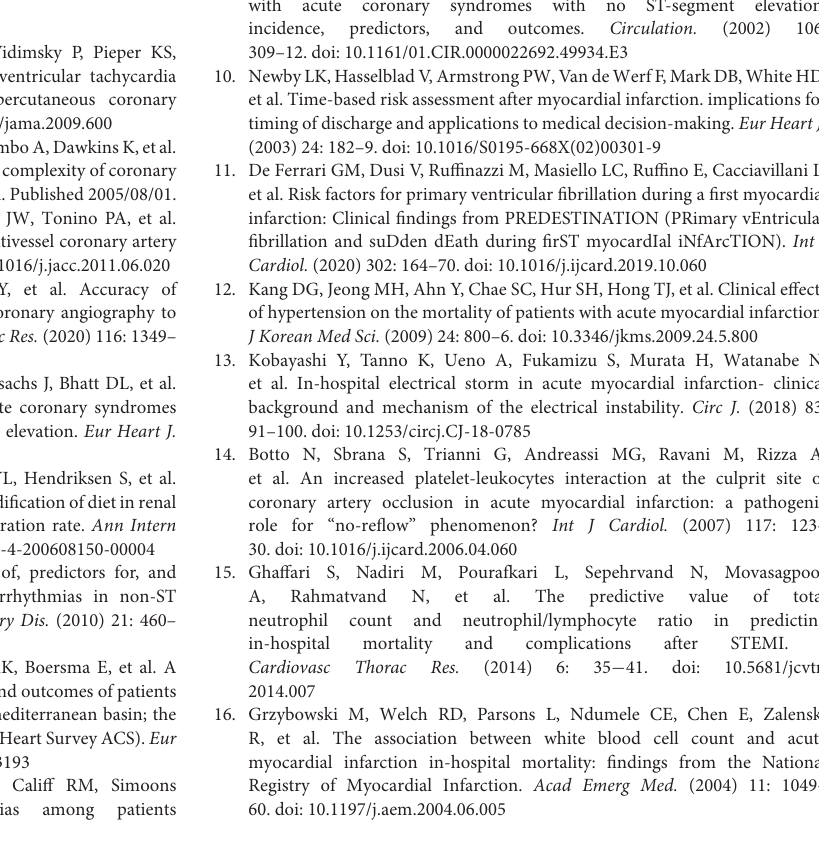
Supplementary Figure 1 | Proportions of the study population according to the tertiles of the SS. Supplementary Figure 2 | Incidence of VT/VF between low-risk, medium-risk, and high-risk groups of SS and FSS caFFR . Supplementary Table 1 | Angiographic date of patients in the non-VT/VT group and the VT/VF